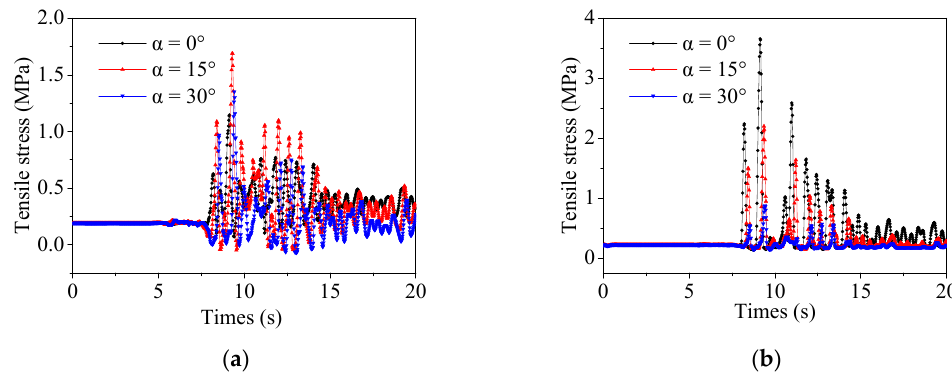
Figure 24. Tensile stress time history of the shear key: ( a ) shear key B; ( b ) shear key E.